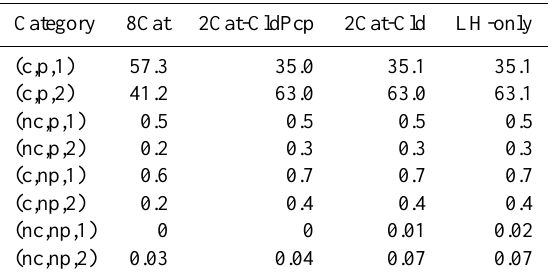
Table 5. DYCOMS-II RF02. Percentage of sample points allocated to each category by each sampling method at the importance sam- pling level, time-averaged over the entire simulation. The more sample points placed in a particular category, the better the estimate of processes active in that category.